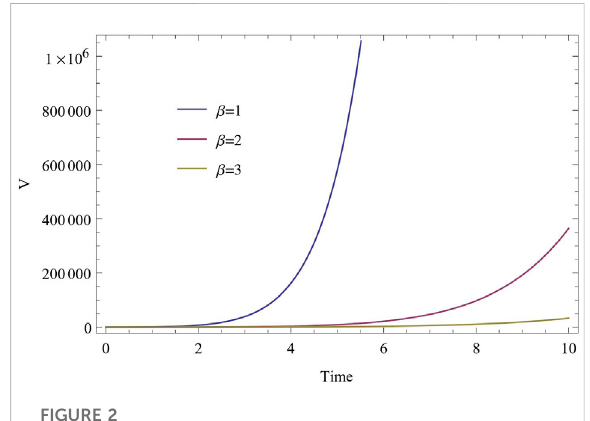
FIGURE 2 The plot of spatial volume V versus time